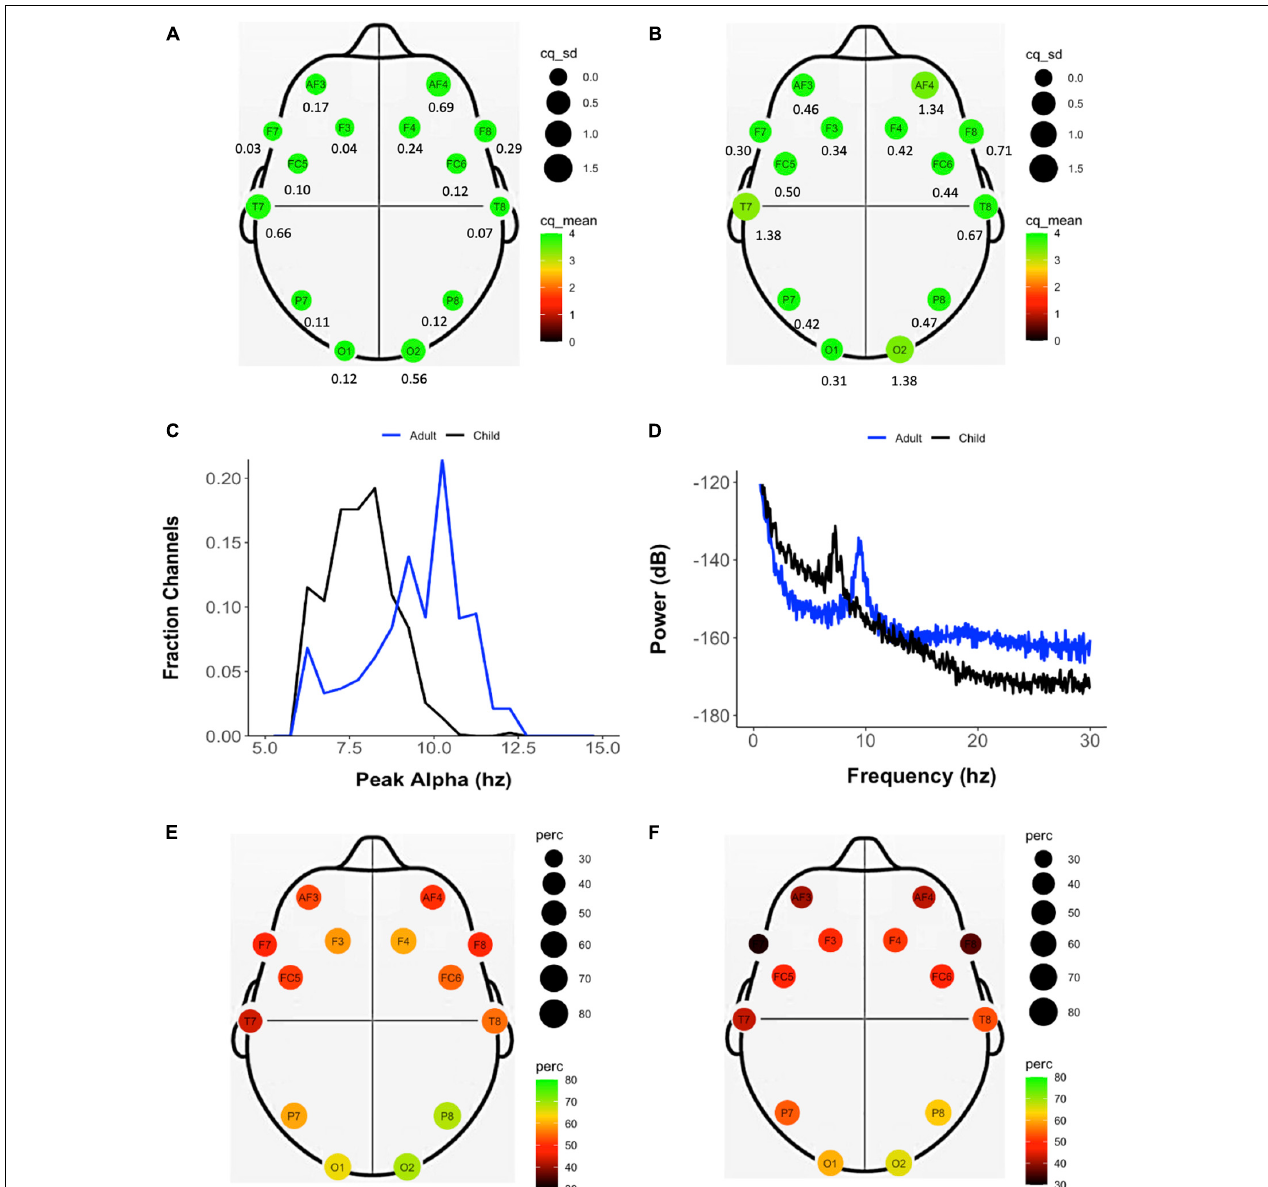
FIGURE 3 | Properties of the EEG data recorded during eyes-closed resting state across the study sample of adults and children. Mean (color and size coded) and standard deviation (reported below each electrode location) of the channel quality of each electrode in adults (A) and (B) children. (C) Frequency of peak alpha (Pa) calculated individually for each channel in adults (blue) and children (black). (D) Power spectrum derived from representative EEG recordings from adults (blue) and children (black). Frequency (color and size coded) of presence of an alpha peak at each electrode location in adults (E) and children (F)